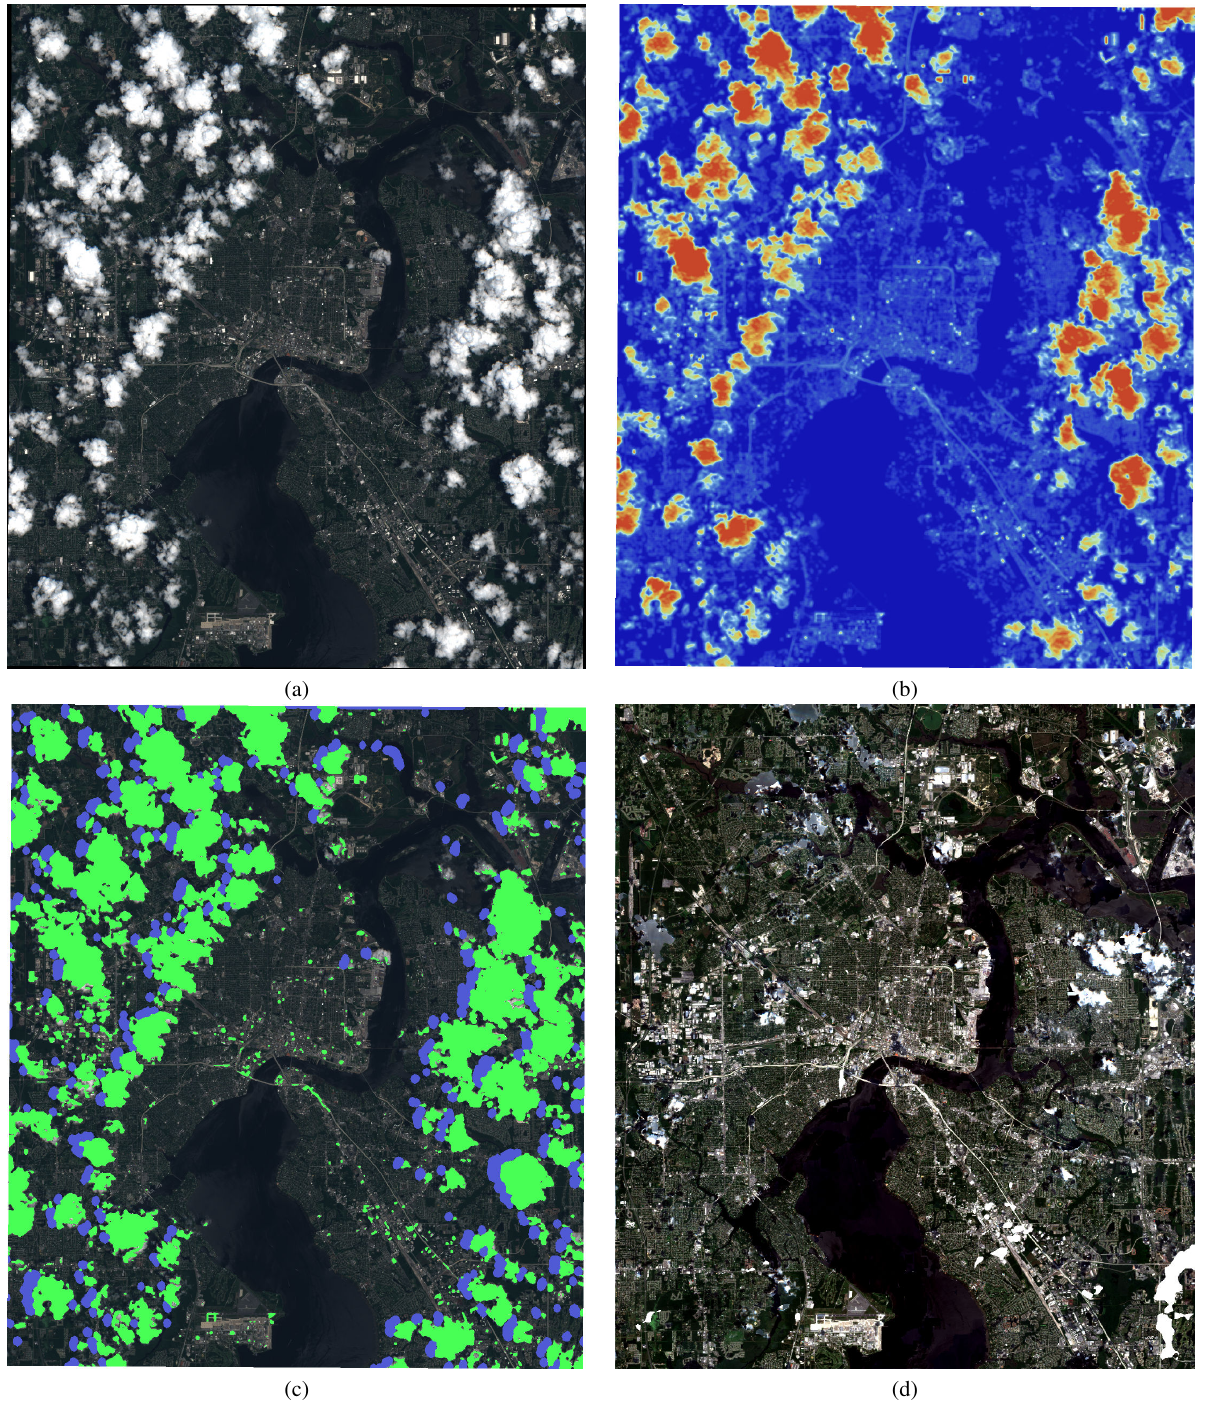
Figure 7. The cloud-free image generation process. (a) The original image from the collection with the least cloud cover for Jacksonville, Florida in winter, (b) computed cloud score for the image, with a color scale from blue (low cloud probability ) to red (high cloud probability), (c) cloud and shadow mask computed by thresholding the Quality Score with green representing the cloud contribution and blue the shadow, and (d) the final cloud-free image produced for the